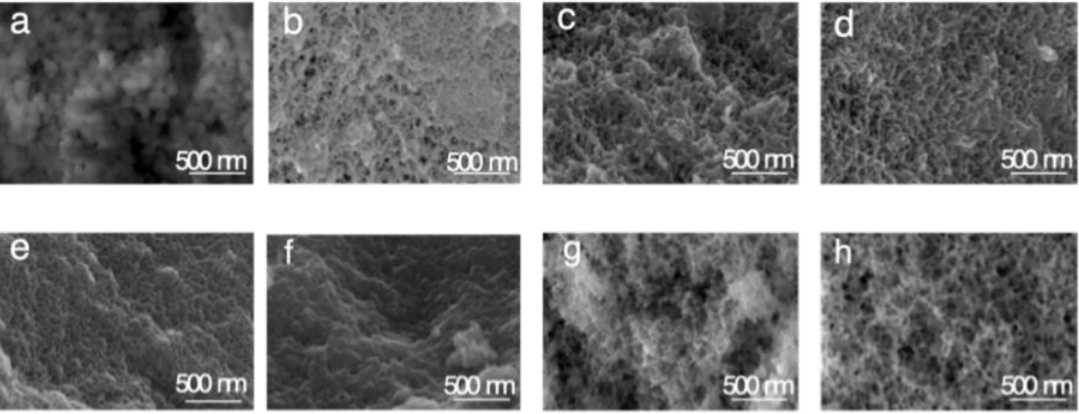
Figure 2. SEM of various samples: ( a ) RF ( b ) MPR110-EW, ( c ) MPR220-EW ( d ) MPR110-EW-P1 ( e ) MPR110-EW-P3 ( f ) MPR110-W-P1 ( g ) MPR110-W-P3 and ( h ) MPR220-EW-P3. (500